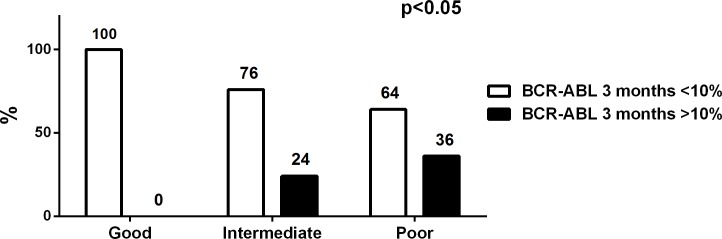
A third of the poor responders do not achieve a BCR-ABL1 transcript level<10% at 3 months.Using the 3-month BCR-ABL1 transcript 10% classification, 36% of the poor responders had BCR-ABL1 transcripts>10%, whereas 0% of good responders (FC<0.31) and 24% of the intermediate responders (0.31<FC<1) were categorized into this group (see Fig 1A for classification of patients). Statistical significance was analyzed with a chi-square test.